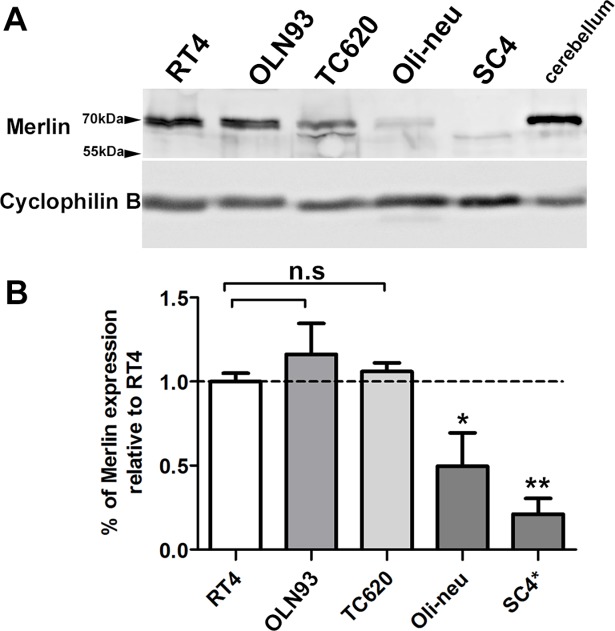
Quantification of Merlin expression in cerebellar tissue, cell lines and primary cell cultures.(A) Merlin expression is demonstrated by Western blotting loading 30 μg of total protein extract. Merlin was expressed as a 70kDa sized protein in RT4, OLN93, TC620 and Oli-neu cell lines; it was absent in SC4 cells. Western blots have been repeated three times with different samples and densitometrically evaluated (B). Expression levels have been related to the expression of Merlin in RT4 cells marked by the dashed line. Significant differences in expression of Merlin in oligodendrocyte cell lines vs. RT4 are marked by asterisks (mean ± SEM, n = 3; *** p < 0.001, ** p < 0.05 t-test).